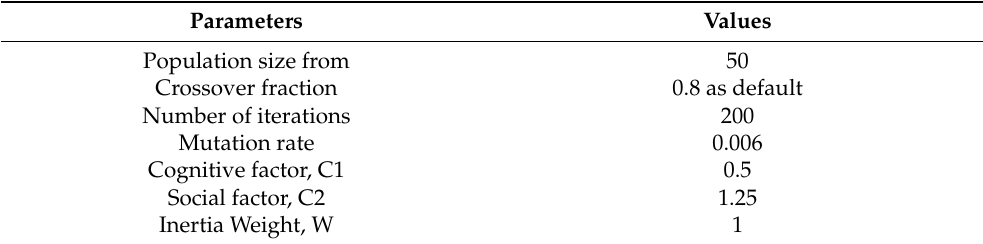
Table 5. Specifications and parameters of hybrid